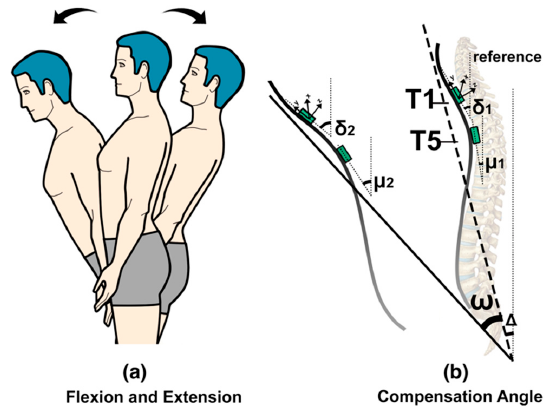
Figure 3. Calibration model of flexion and extension movement of torso.